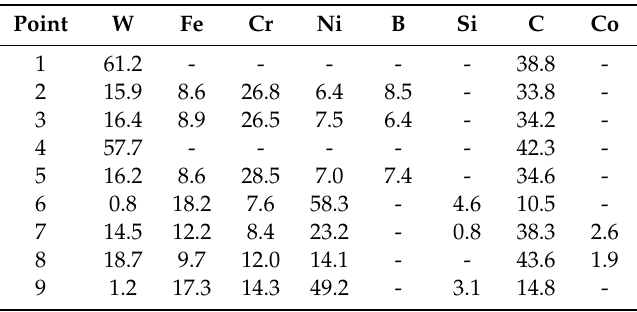
Table 3. The scanning electron microscope equipped with an energy-dispersive spectrometer (EDS) analysis results of the cladding